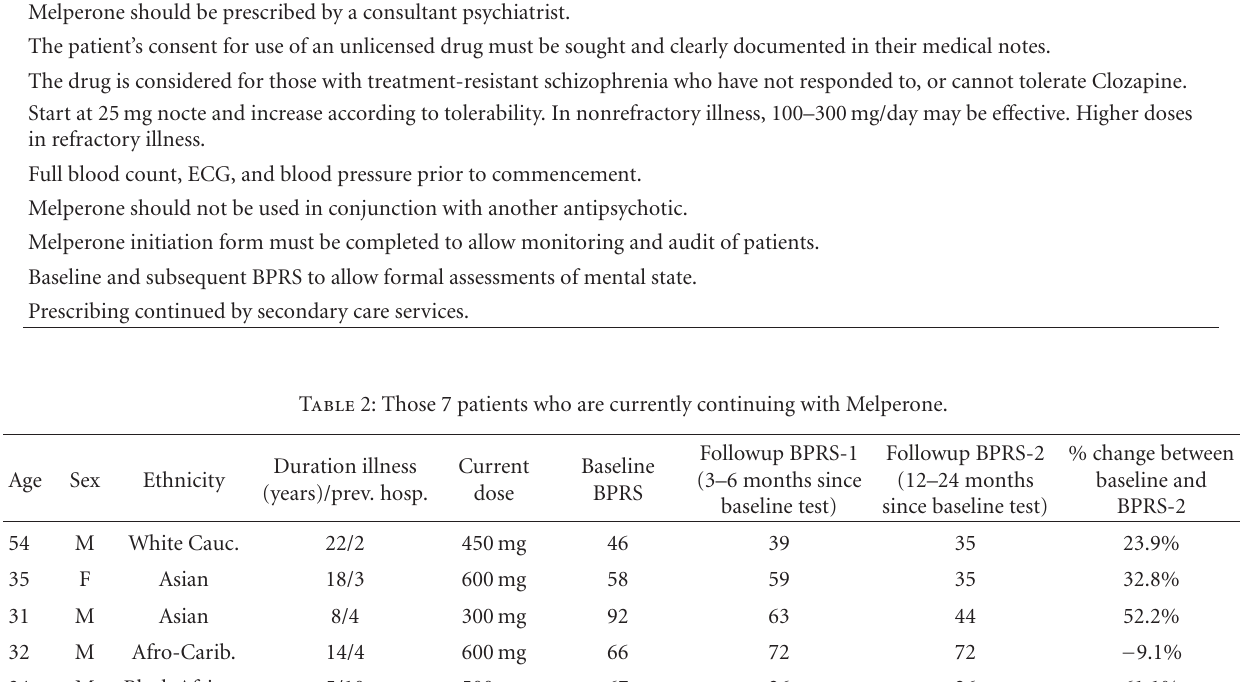
Table 1: Guidelines and requirements for the use of Melperone as defined within ELFT medicines committee policy. Melperone should be prescribed by a consultant psychiatrist.